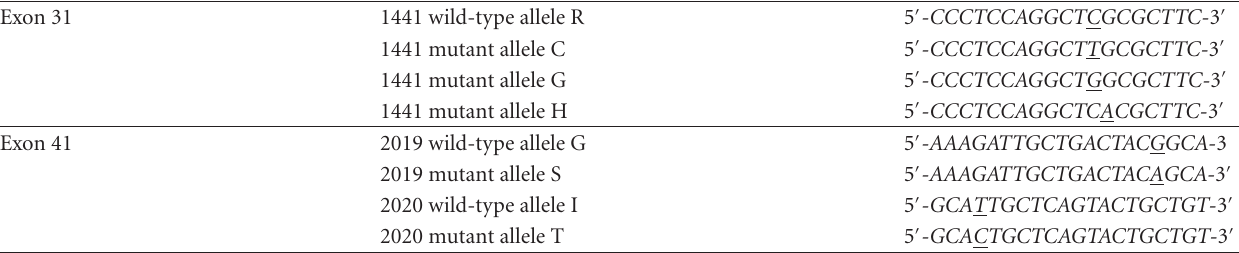
Table 1: Oligonucleotides used for the ASOs technique. The nucleotide change in the oligonucleotides is